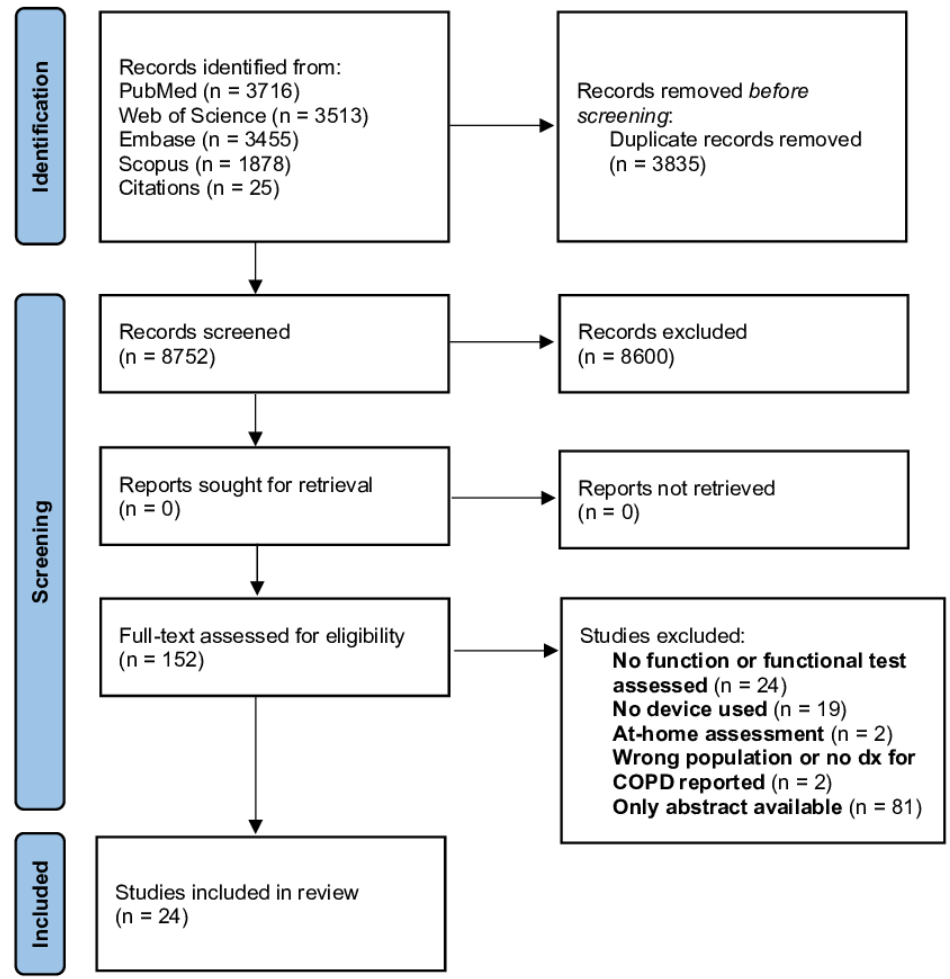
Figure 1. Flow diagram of the included studies. COPD, chronic obstructive pulmonary disease.